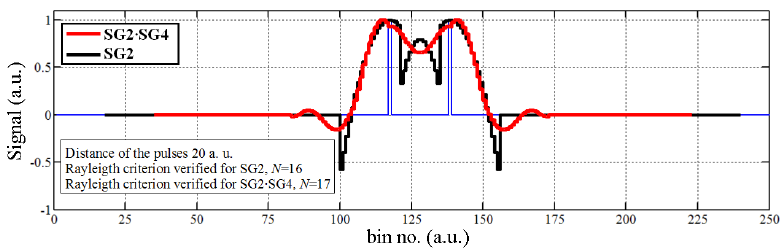
Figure 9. The Rayleigh criterion applied to 2 unitary pulses (1 bin thick and at a distance of 20 bins) in the case of the SG2 filter (black line) and of the SG2 · SG4 filter (red line). The cascaded filter does not exhibit the appearance of central “bump”. The N values in legend indicate the maximum possible value to resolve the two smoothed pulses.